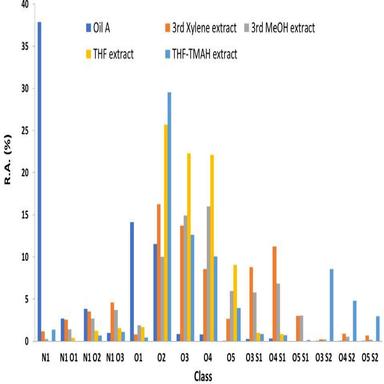
Class distribution of oil A, the 3rd xylene extract, the 3rd methanol extracts as well as the 1st THF extract and the 1st THF-TMAH in (−)ESI.